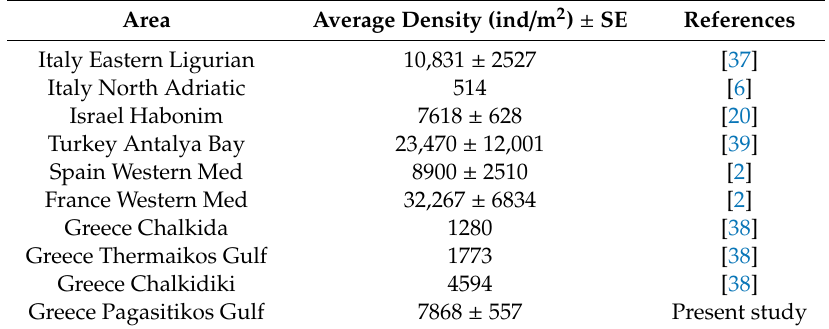
Table 7. Abundance of C. stellatus populations reported from various Mediterranean